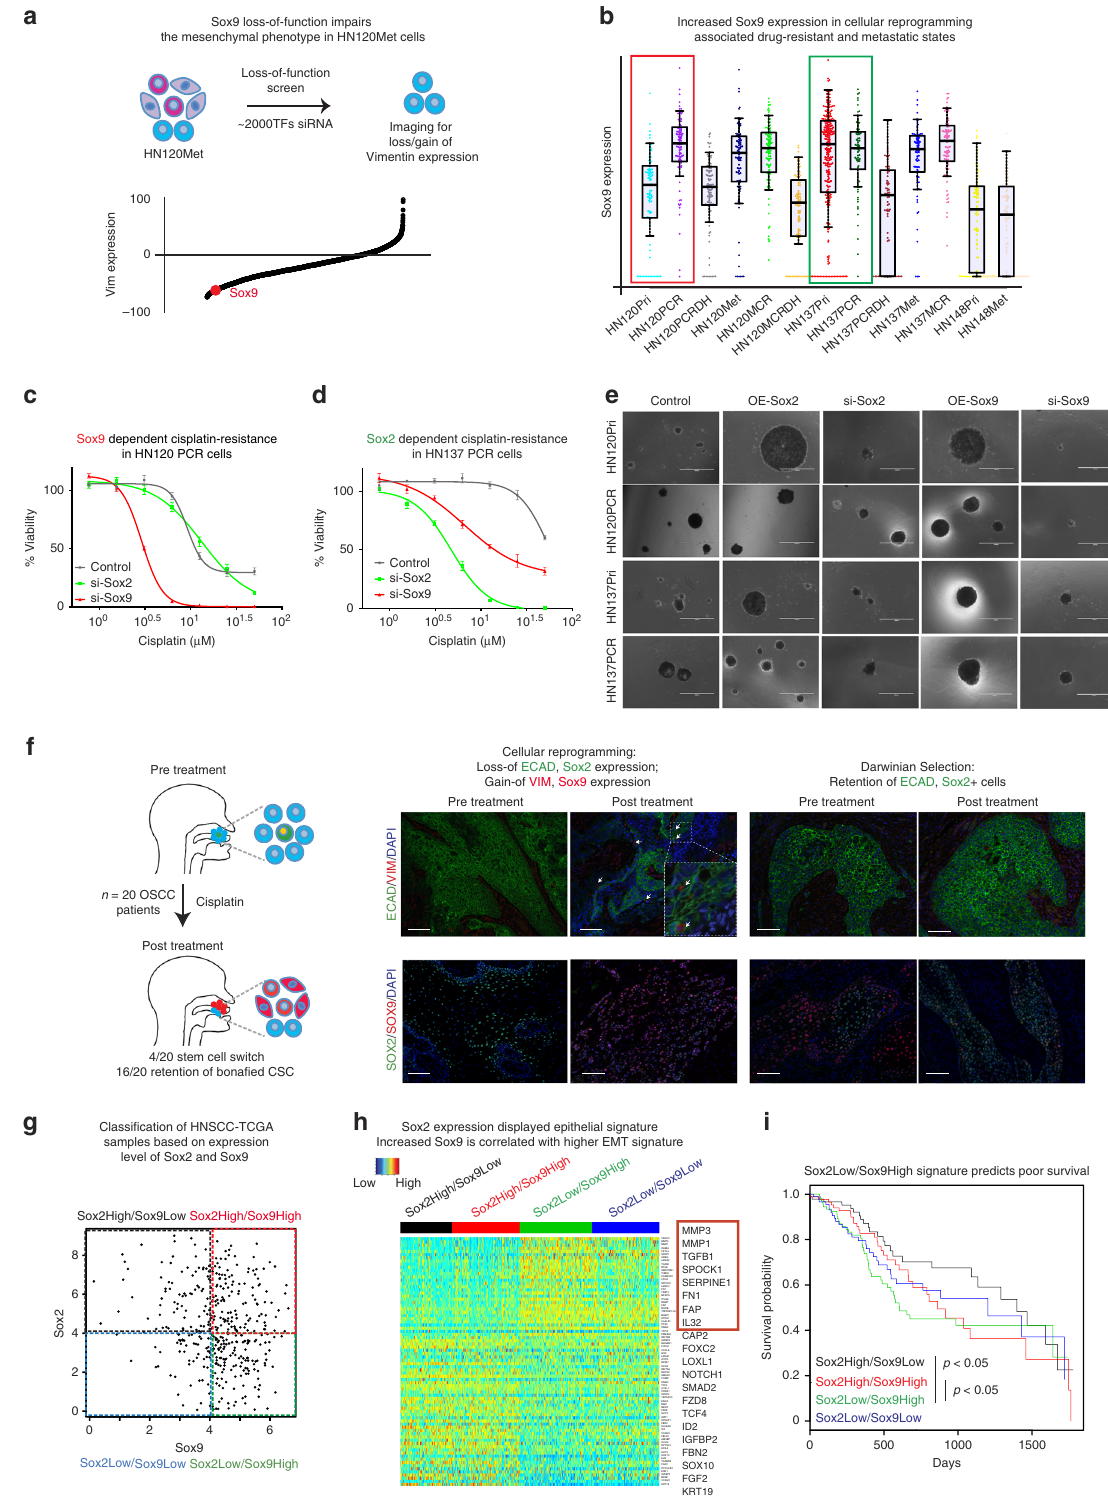
alternative dependencies on stem factors between the two models (Supplementary Figure 10d). Taken together, these results validate the divergent role of SOX2 and SOX9 in maintenance of drug-resistance and cell-state phenotypes in OSCC. Validation of drug-induced stem cell plasticity in OSCC patients . To validate whether the interplay between SOX2 and SOX9